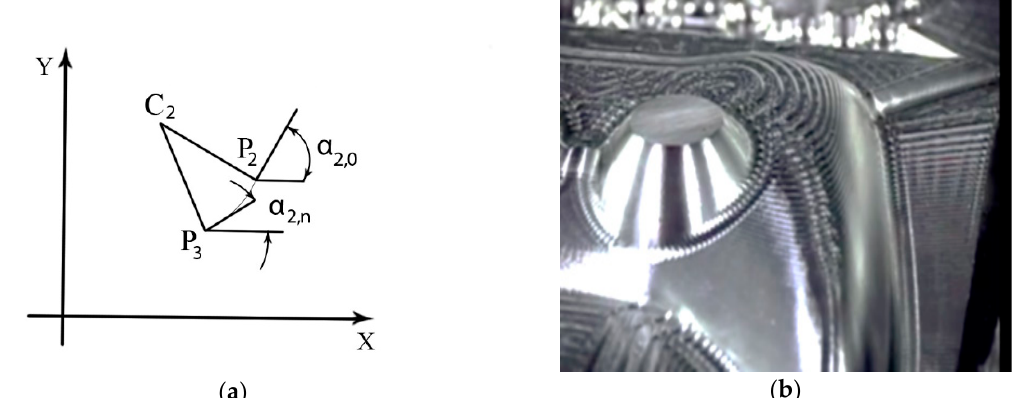
Figure 4. The arc between the limit positions and variable geometric shape deviations without 2 1 / 2 D control. ( a ) The arc between the limit positions; ( b ) Variable geometric shape deviations.